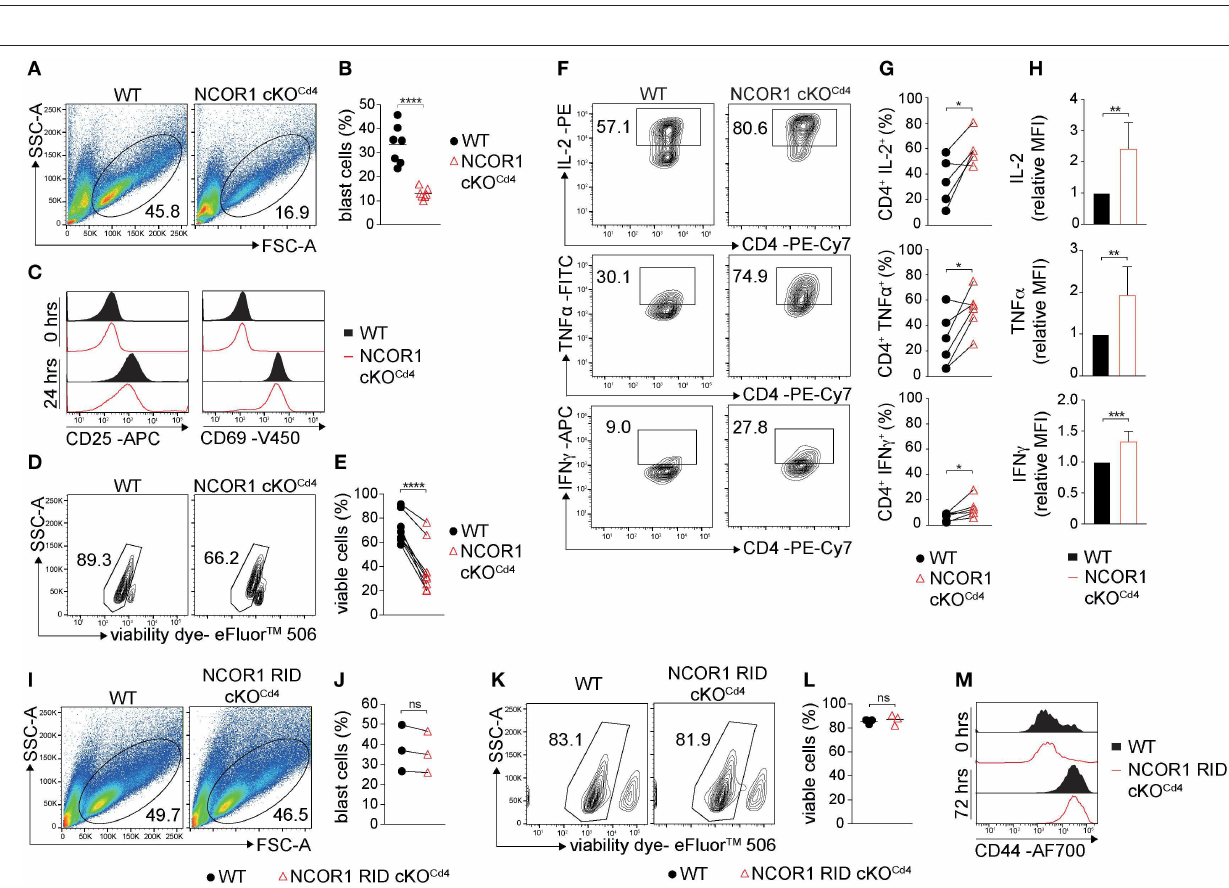
FIGURE 1 | (C) Sequence shows DNA-binding motif enriched within NCOR1 recruitment sites as revealed with the Bioconductor rGADEM package. (D) Venn diagrams showing an overlay of NCOR1-bound genes (gray) with genes that are up- (left Venn diagram) and downregulated (right Venn diagram) in NCOR1-deficient naïve CD4 + T cells. (E) Gene set enrichment analysis (GSEA) plots generated from RNA-seq expression data of WT and NCOR1 cKO Cd4 naïve CD4 + T cells. Gene sets of the hallmark gene set collection of the Molecular Signature Database (MSigDB) were used. The top 6 enriched hallmark gene sets are shown. A detailed list of